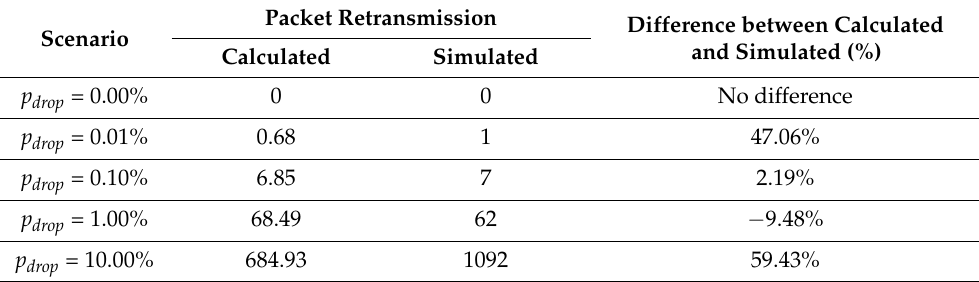
Table 7. Packet Retransmission (Calculated and